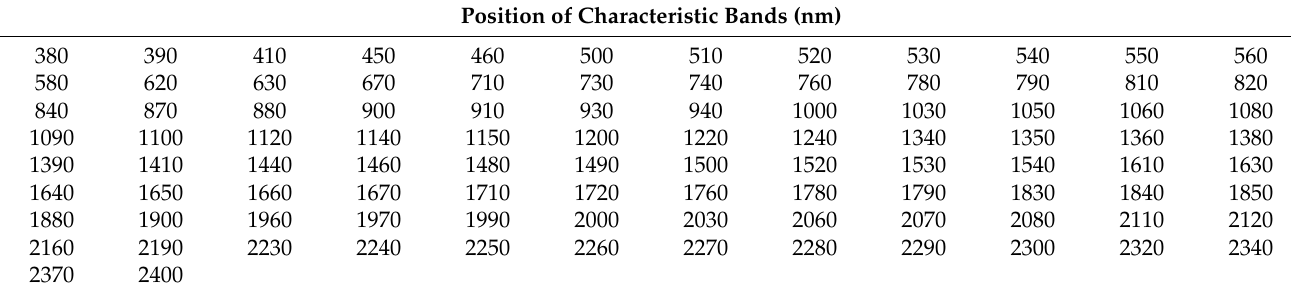
Table A3. Characteristic bands of CR-FD selected by GA. Position of Characteristic Bands (nm)